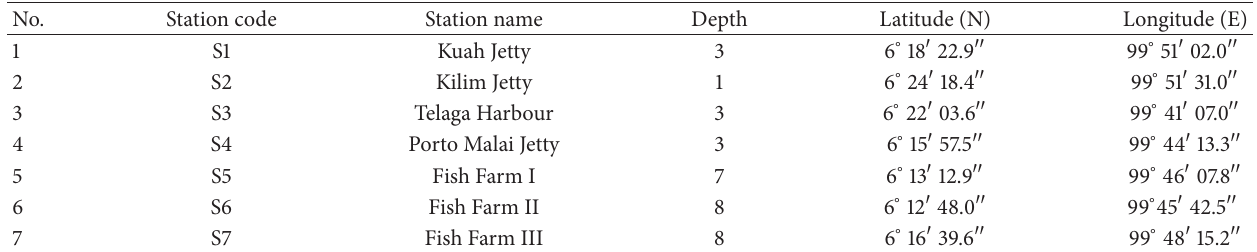
Table 1: Sampling locations and associated water depths